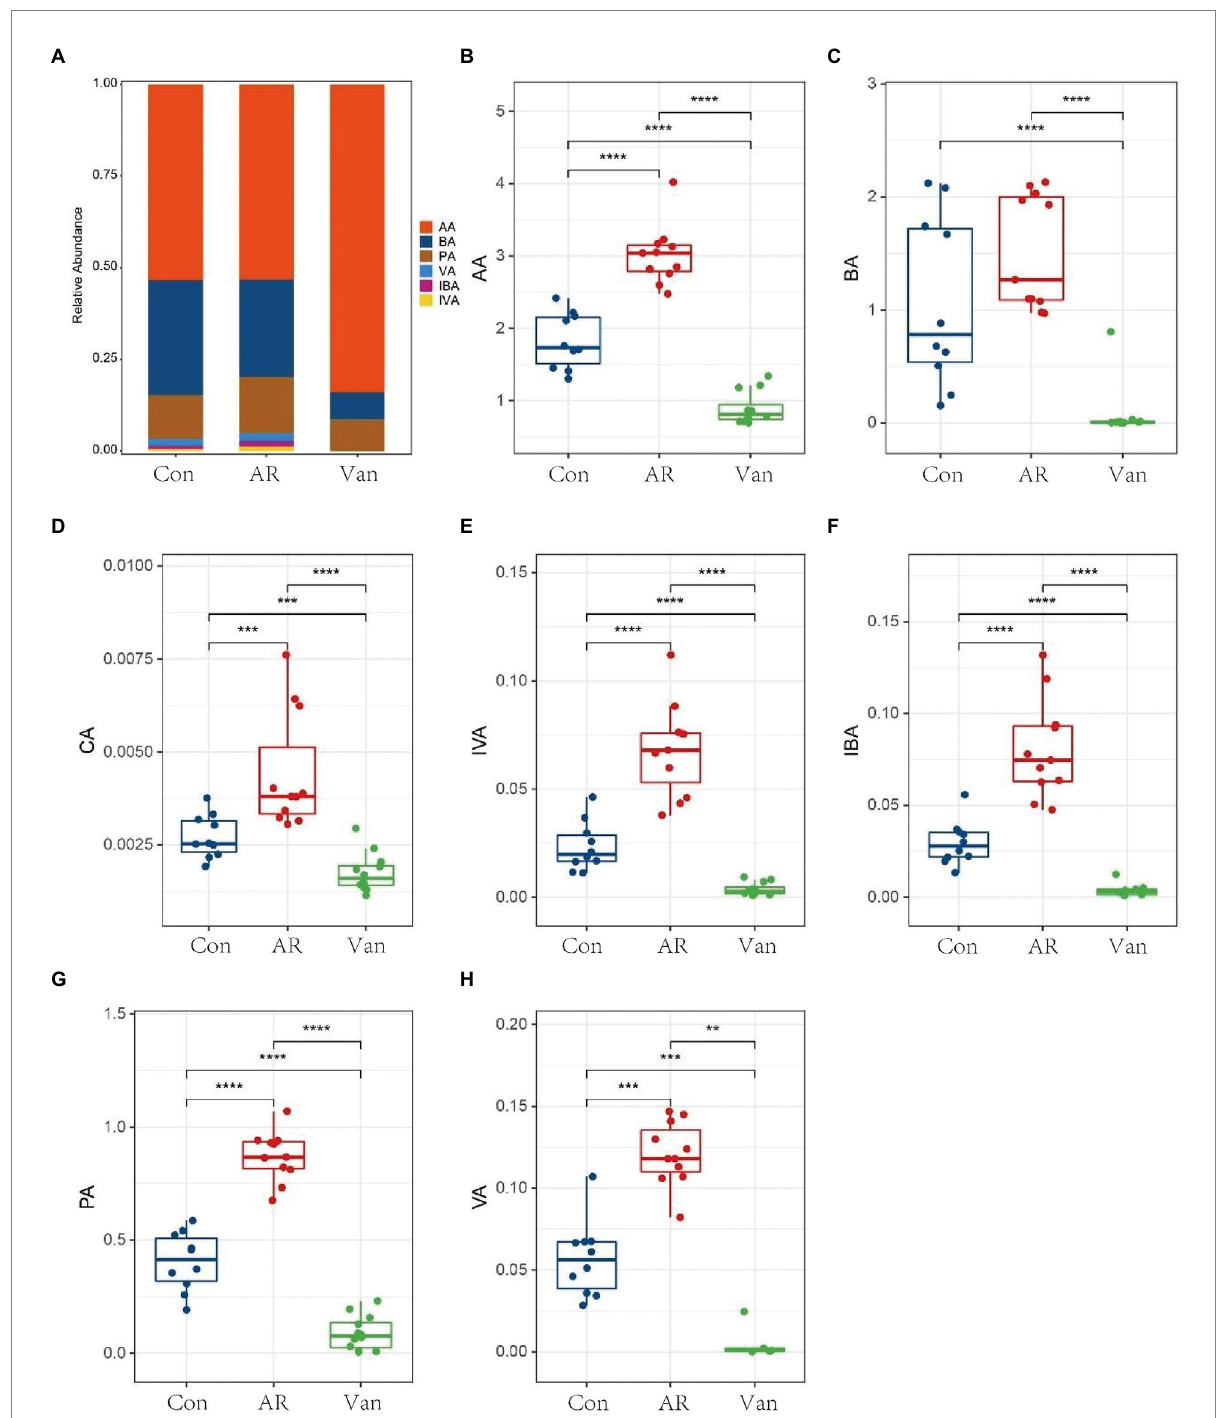
FIGURE 8 Determination of short-chain fatty acids in mouse feces based on metabolomics. (A) Histogram shows the average proportion value of short- chain fatty acids, (B–H) changes in short-chain fatty acids in feces of mice in the control group (Con), AR model group (AR), and vancomycin- induced gut microbiota dysbiosis AR model group (Van). ** p < 0.01, *** p < 0.001, **** p <